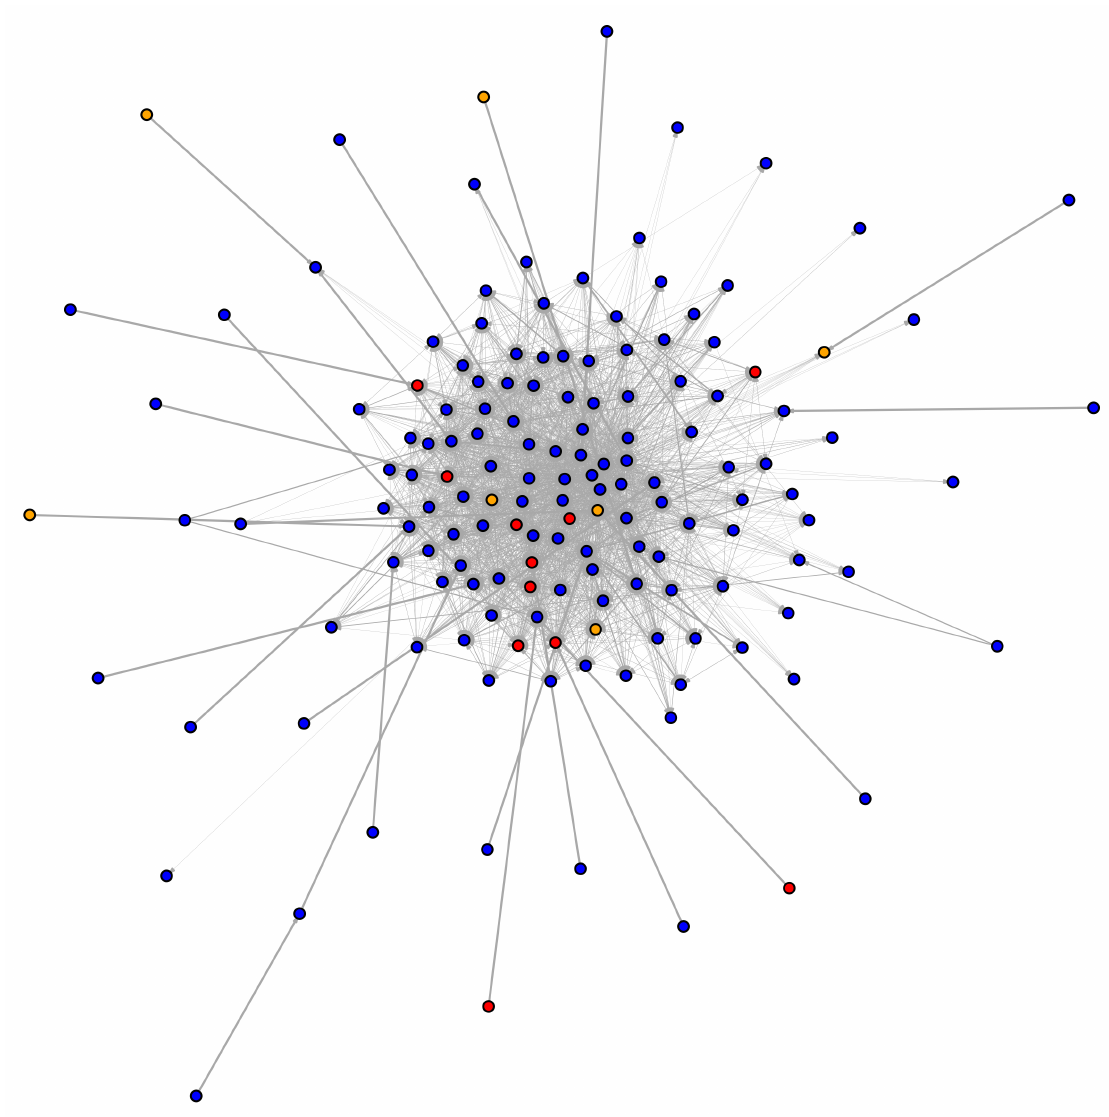
Figure 2. Weighted and directed social network in a manufacturing company built upon e-mail communication. The colouring scheme is the same as for Figure 1: red nodes—first level management, orange nodes—second level management, blue nodes—regular employees. The algorithm used for visualisation is a force-directed large graph layout [39] with the root node with the highest